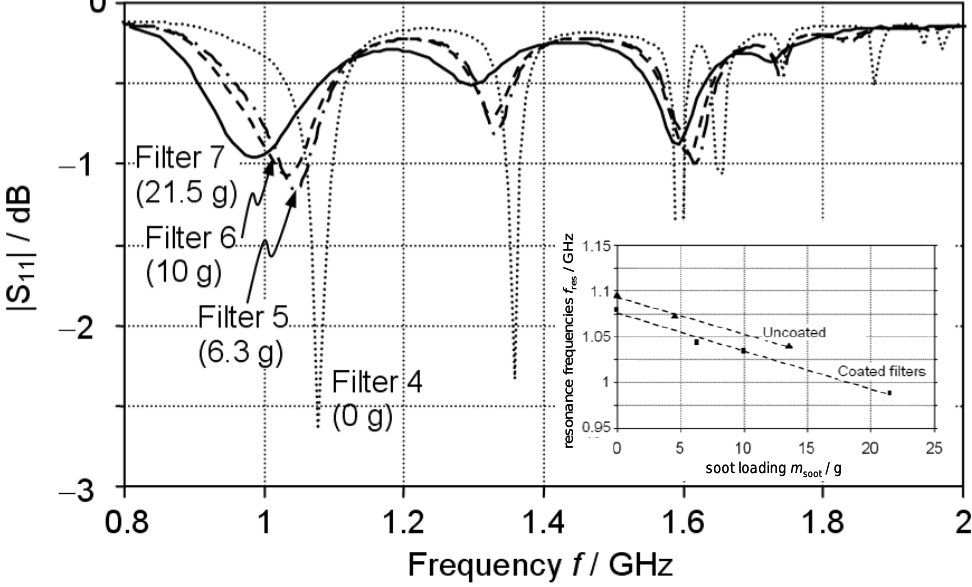
Figure 9. Reflection spectra obtained for DPFs with different soot loadings as indicated. DPF volume: 2.3 liter. Please note: in contrast to Figure 7, | S after [43], reprinted with permission from Institute of Physics and IOP Publishing